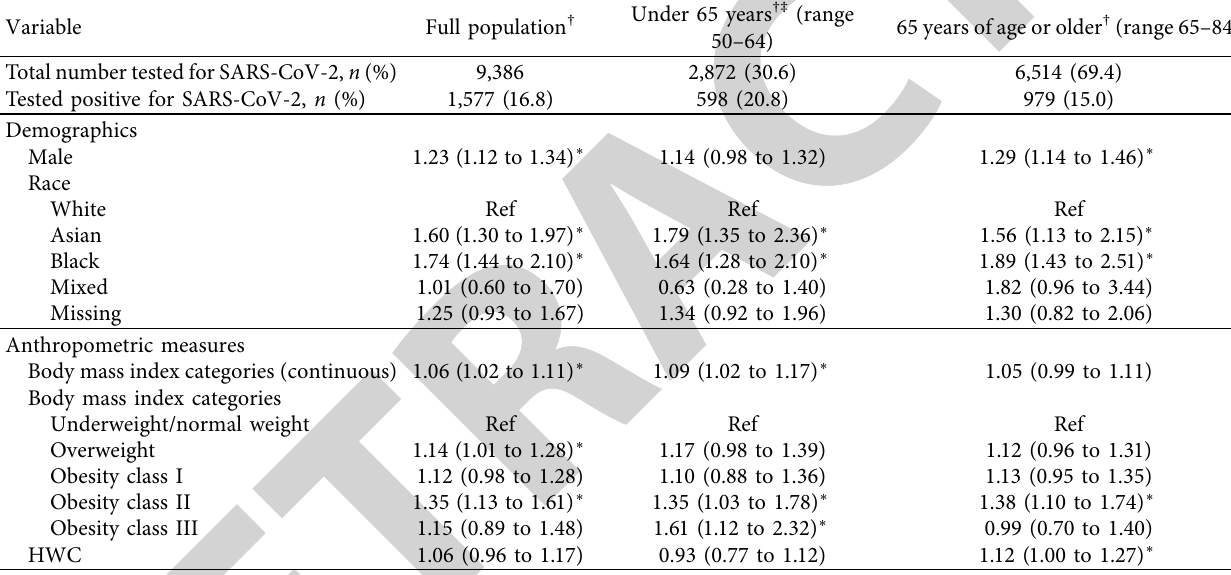
Table 3: Association between measures of adiposity and testing positive for SARS-CoV-2 overall and stratified by older age.